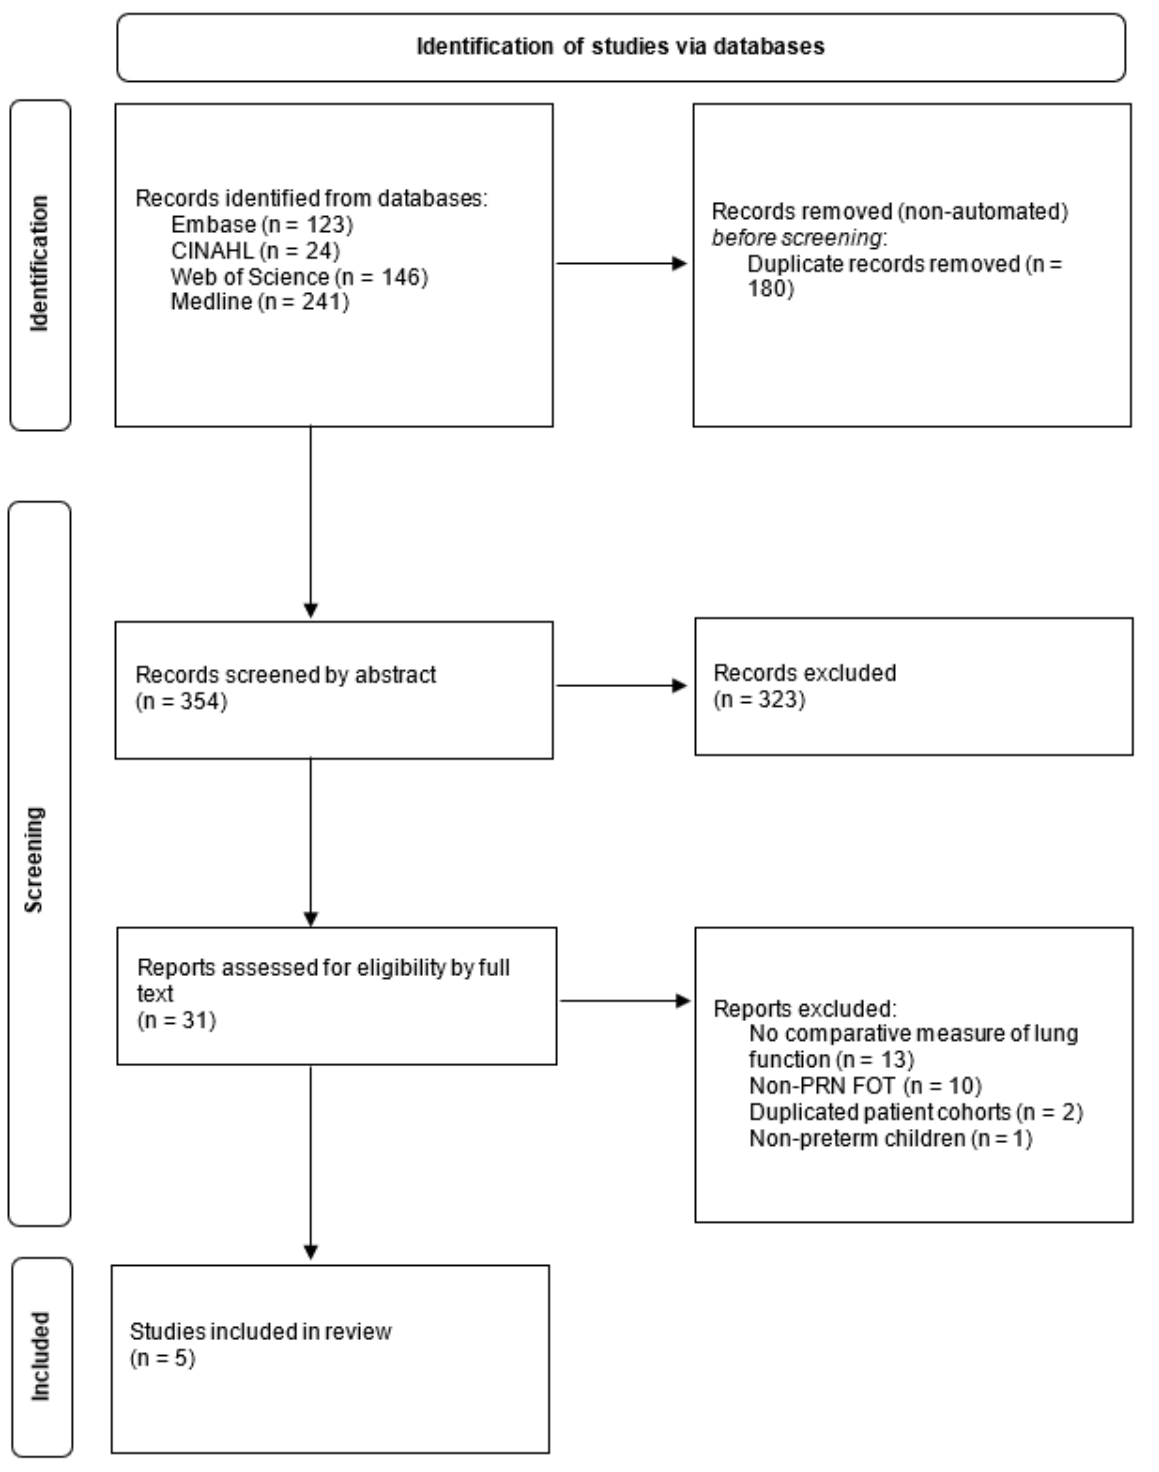
Figure 1. PRISMA flowchart; PRISMA: Preferred Reporting Items for Systematic Reviews and Meta-Analyses